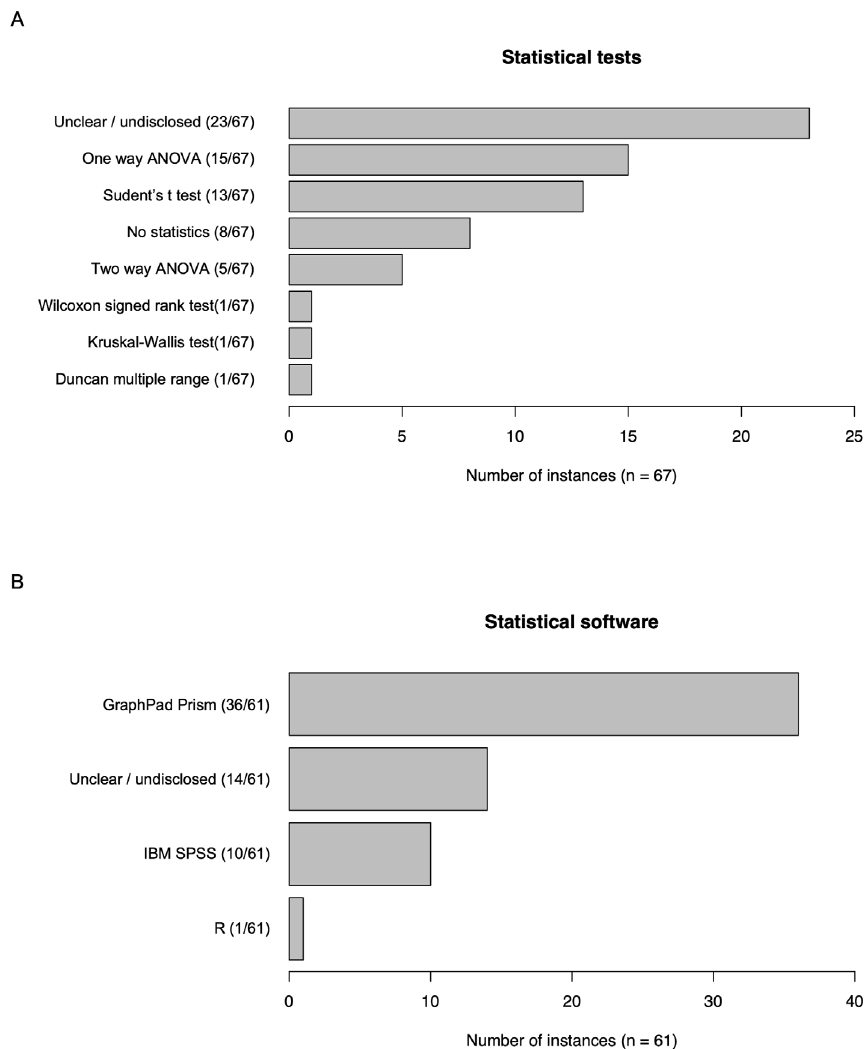
Figure 2. Quanti fi cation of statistical methods (a, study size: n = 67) and software (b, study size: n = 61) in articles ( n = 64) with quantitative